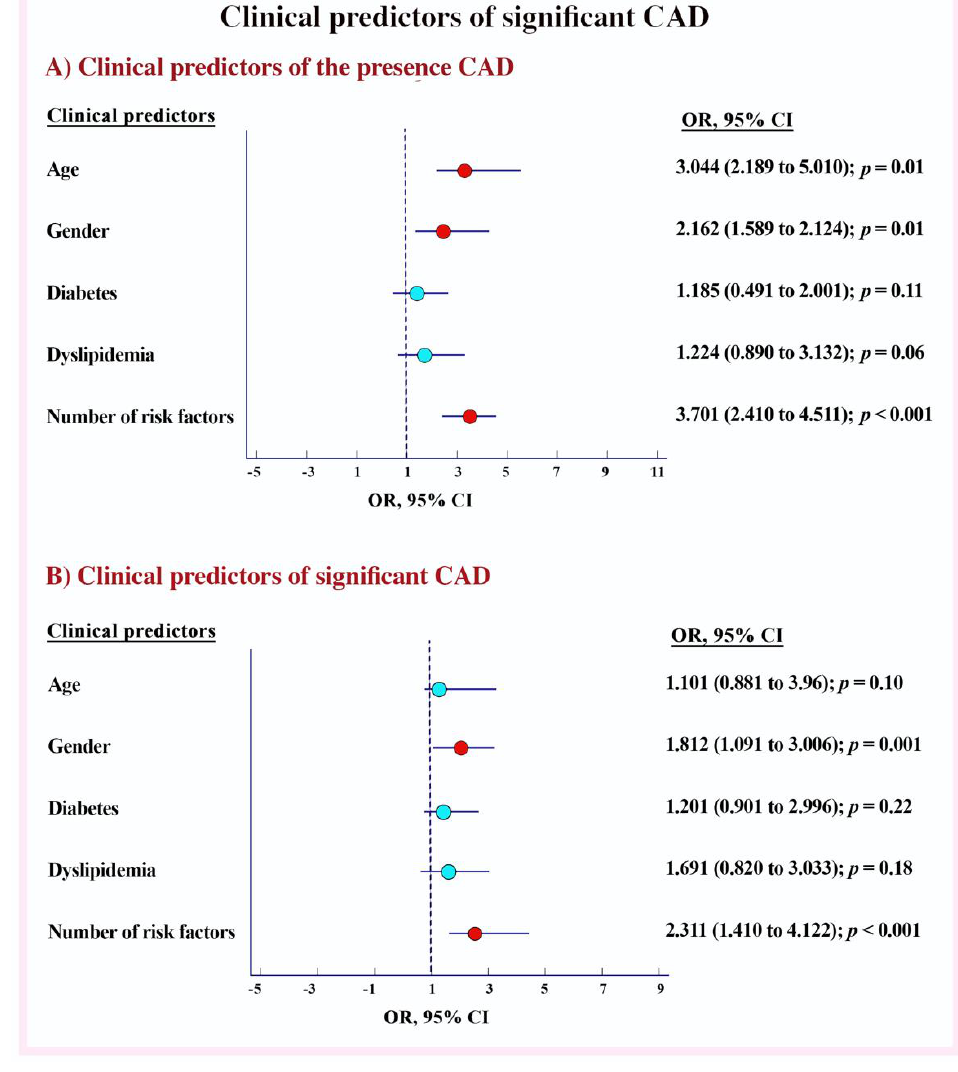
Figure 1. Clinical predictors of significant CAD. ( A ) Clinical predictors of the presence CAD. ( B ) Clinical predictors of significant CAD.